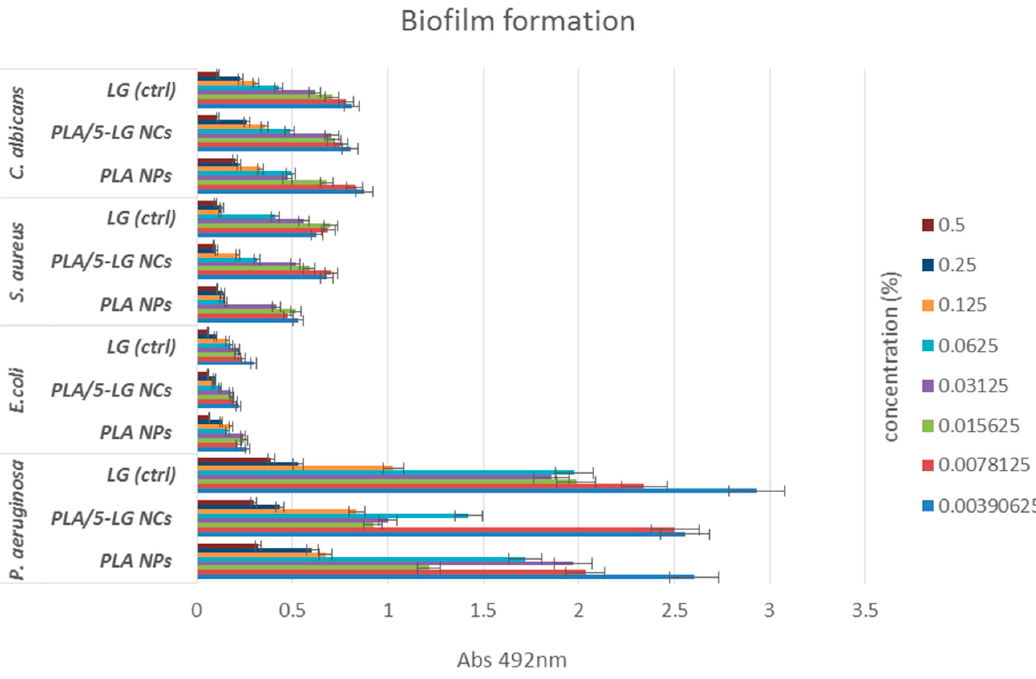
Figure 7. Graphic representation revealing the biofilm inhibition MICs of PLA NPs, PLA/5-LG NCs and LG oil control on the tested microbial strains.